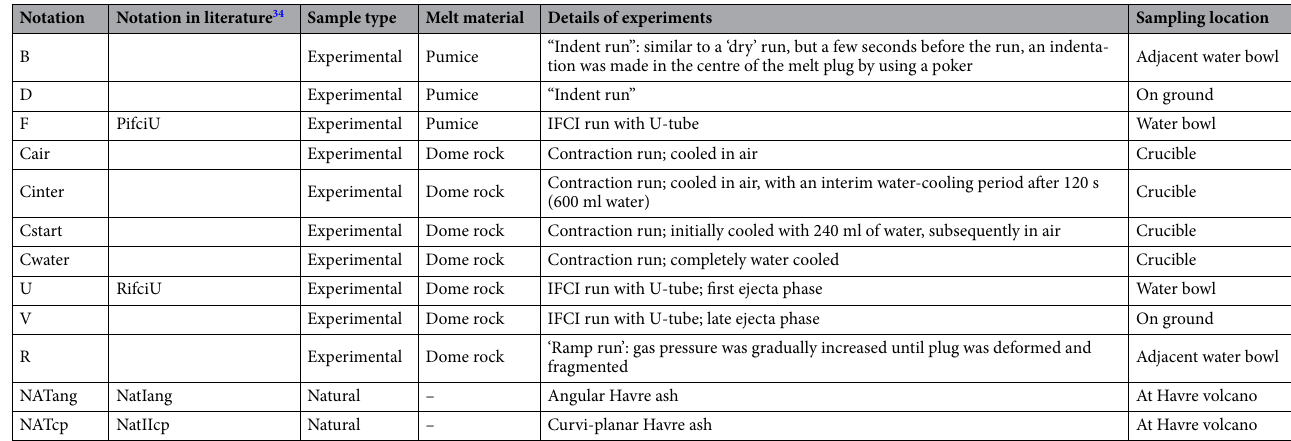
Table 2. List of samples used for DAPM demonstration using